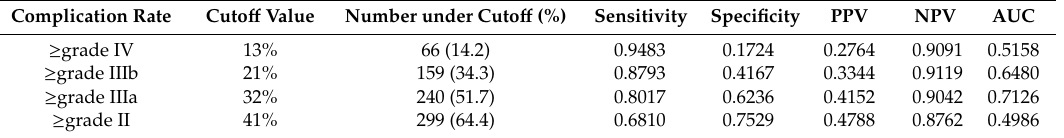
Table 3. Diagnostic characteristics of malignancy prediction according to the cuto ff and the severity of complications in the pancreaticoduodenectomy group ( n =